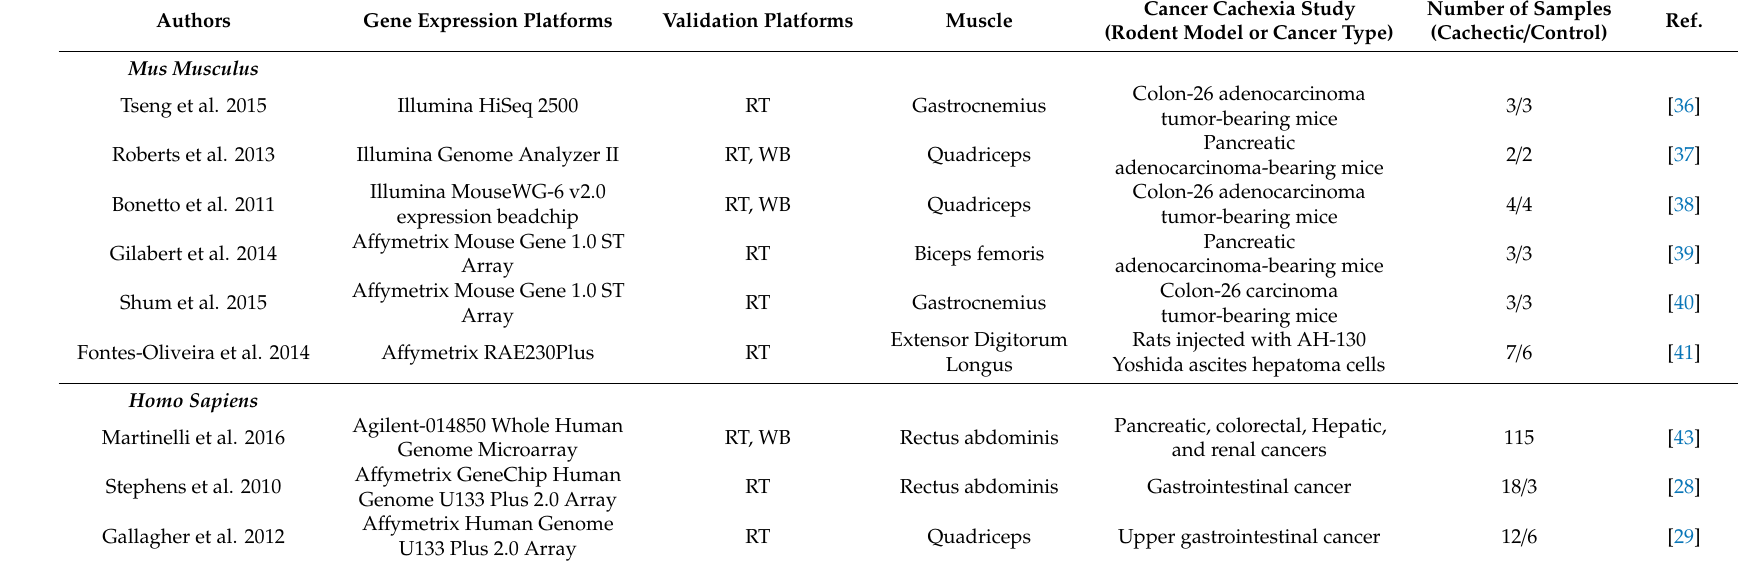
Table 1. Description of publicly available studies used in the